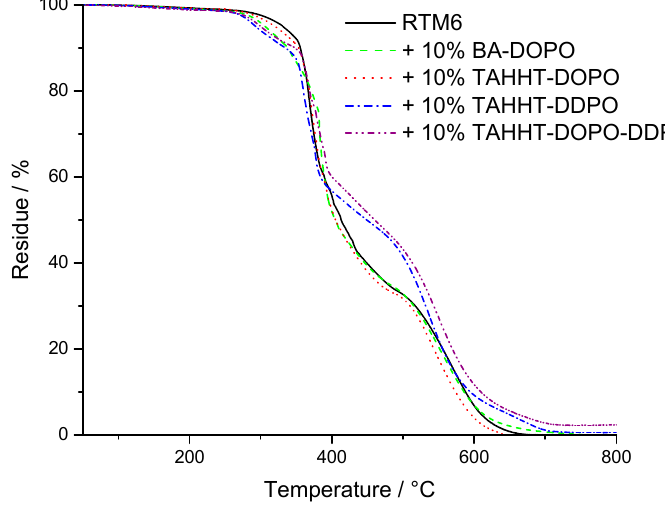
2 -atmosphere. Polymers 2019 , 11 FOR PEER REVIEW